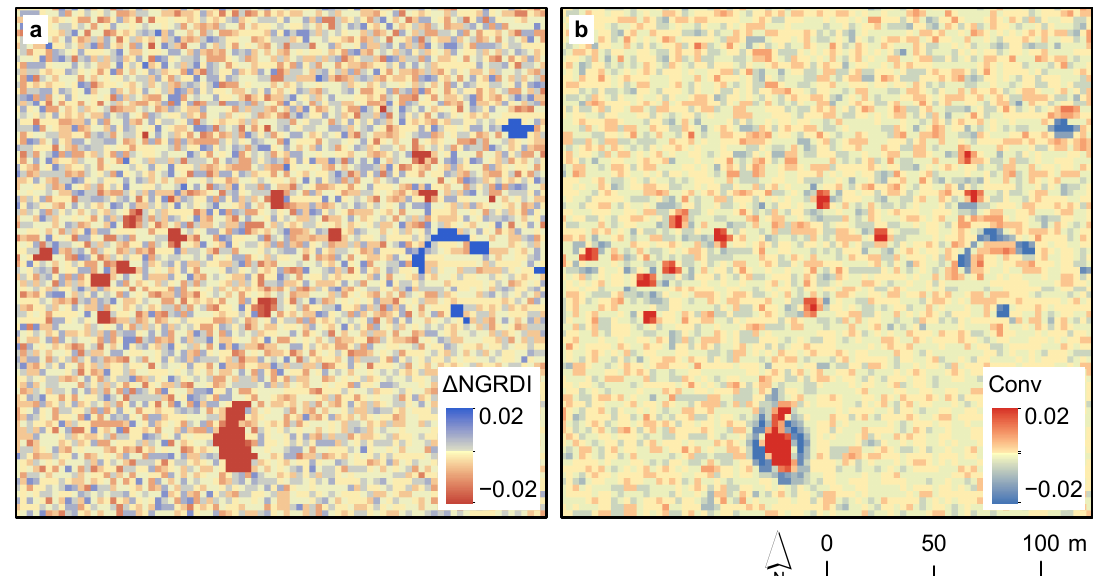
Figure 8. Mapping of the ∆ NGRDI ( a ) and the Conv ( b ) at Site A.